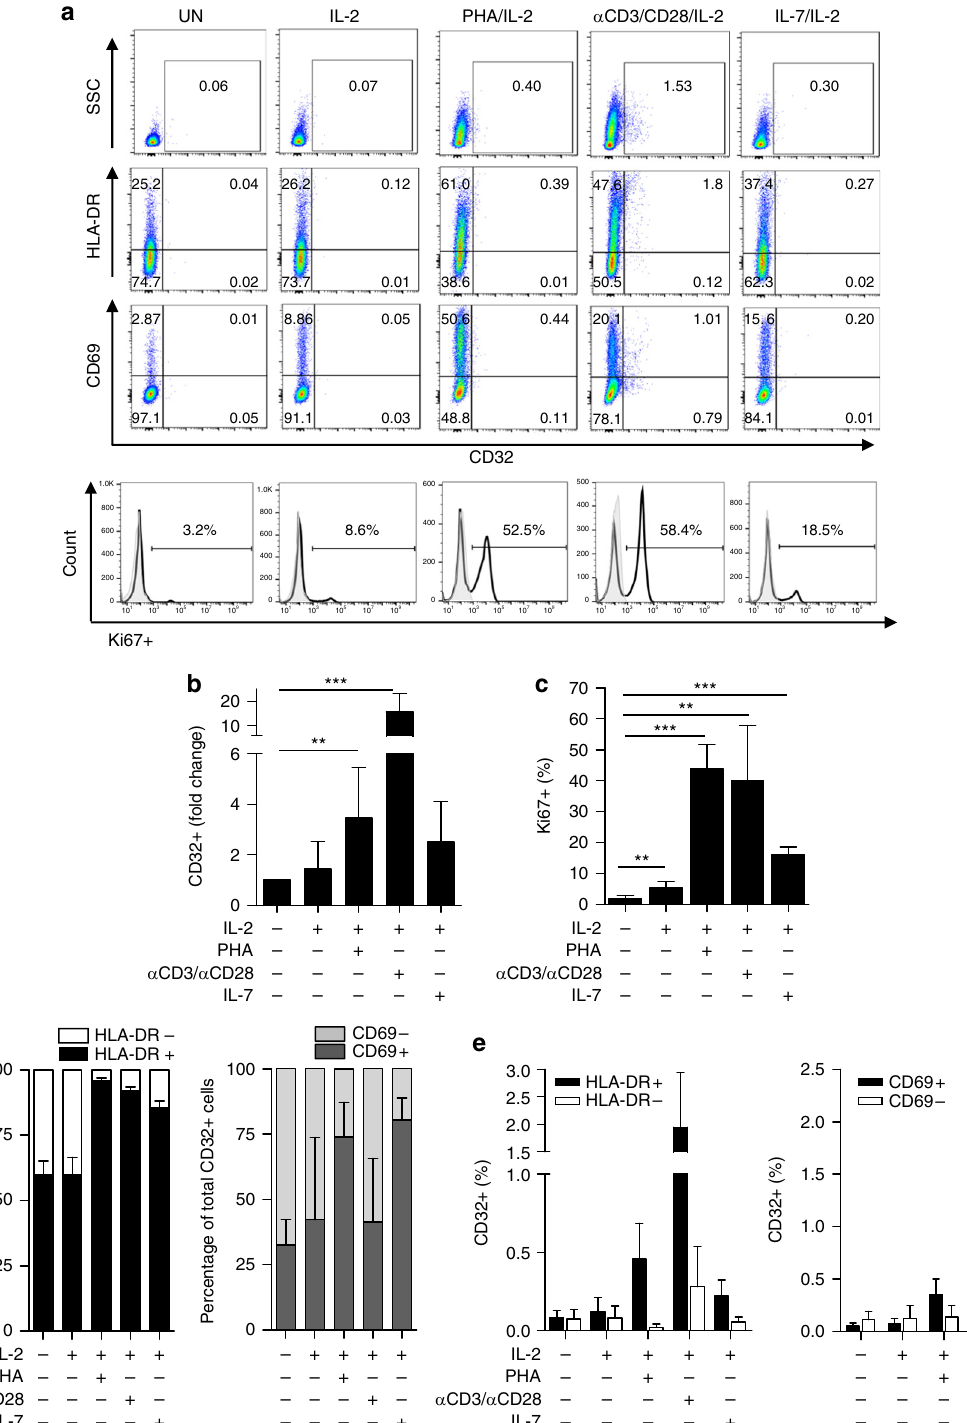
Fig. 1 CD32 is a marker of T-cell activation. a Flow cytometry dot plots showing co-expression of CD32 and markers of cell activation and proliferation in unstimulated (UN) PBMCs or those stimulated with IL-2, PHA/IL-2, α CD3/ α CD28/IL-2, and IL-7/IL-2. A representative donor is shown. b Fold change of CD32 expression in CD4 + T cells unstimulated or stimulated with different conditions from uninfected donors. The cells were cultured in the presence of different stimuli for 72 h, and protein levels of the cell surface marker CD32 were evaluated by fl ow cytometry. c Percentage of Ki67 + cells after activation with different stimuli as in ( a ). d Upregulation of CD32 correlates with the expression of activation markers HLA-DR and CD69 after activation with the different stimuli. Relative contribution of HLA-DR (left panel) or CD69 (right panel) cells over the total population of CD32-expressing cells. e Individual data of HLA-DR cells (left panel) or CD69 (right panel) cells in the CD32 compartment. The gating strategy used to identify CD32 + cells is shown in Supplementary Fig. 1. All panels represent the mean ± SD of at least fi ve different donors. Student ’ s t -test, * p < 0.05, ** p < 0.005, *** p <